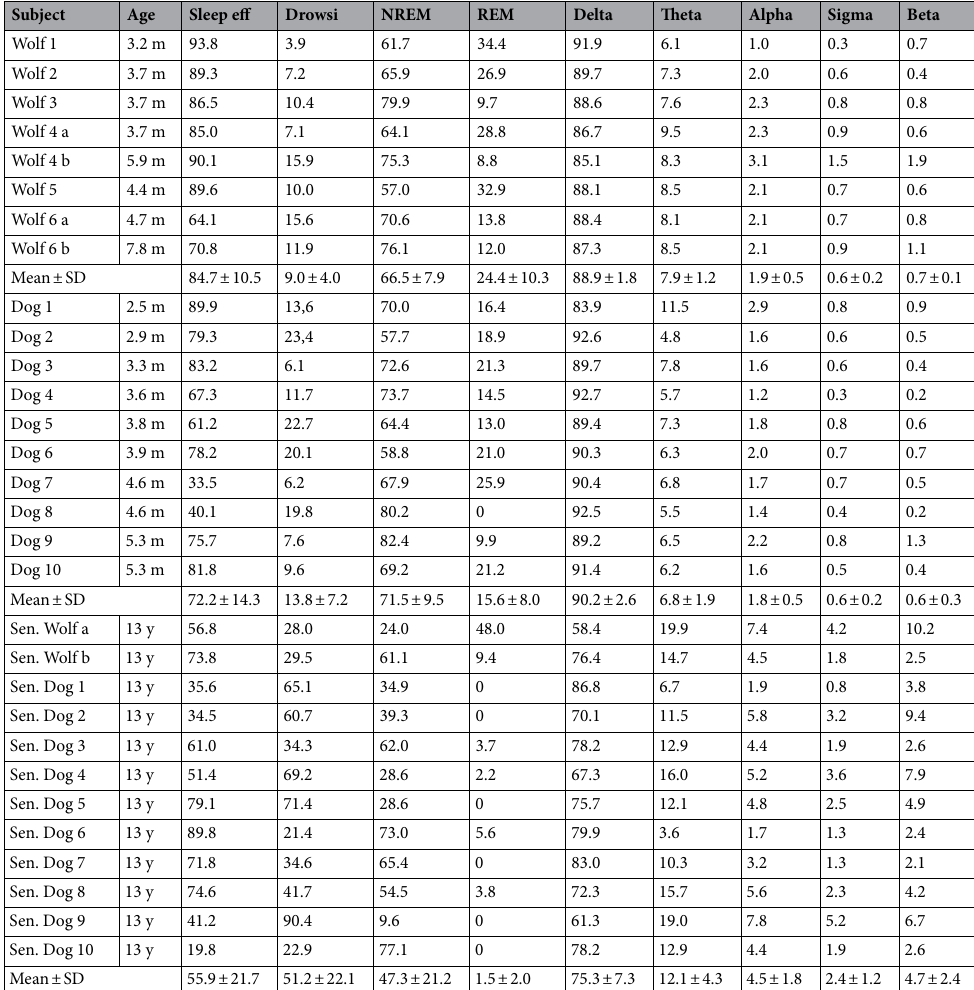
Table 2. Relative sleep macrostructure and spectral variables of individual wolves and dogs. All sleep variables are given in percentage (%). Ages are indicated in months (m) and years (y). Sen. indicates Senior, while ‘a’ and ‘b’ in the subject’s name indicate the first and second sleep